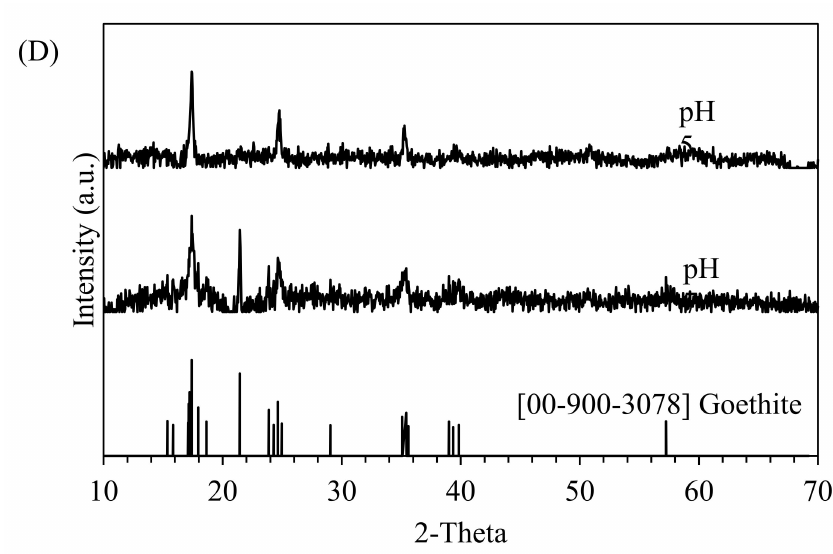
Figure 5. ( A ) CN − removal as a function of the experimental Fe:CN − molar ratio for various control pH values. ( B ) Dissolved Fe(II) and Fe(III) concentration as a function of various pH values at the theoretical Fe:CN − molar ratio of 5.7. ( C , D ) XRD powder pattern of precipitate produced at pH 5 and 7 and theoretical Fe:CN − molar ratio of 0.8. Initial CN − concentration of 10 mg/L. Current intensity of 1 A. Mechanical